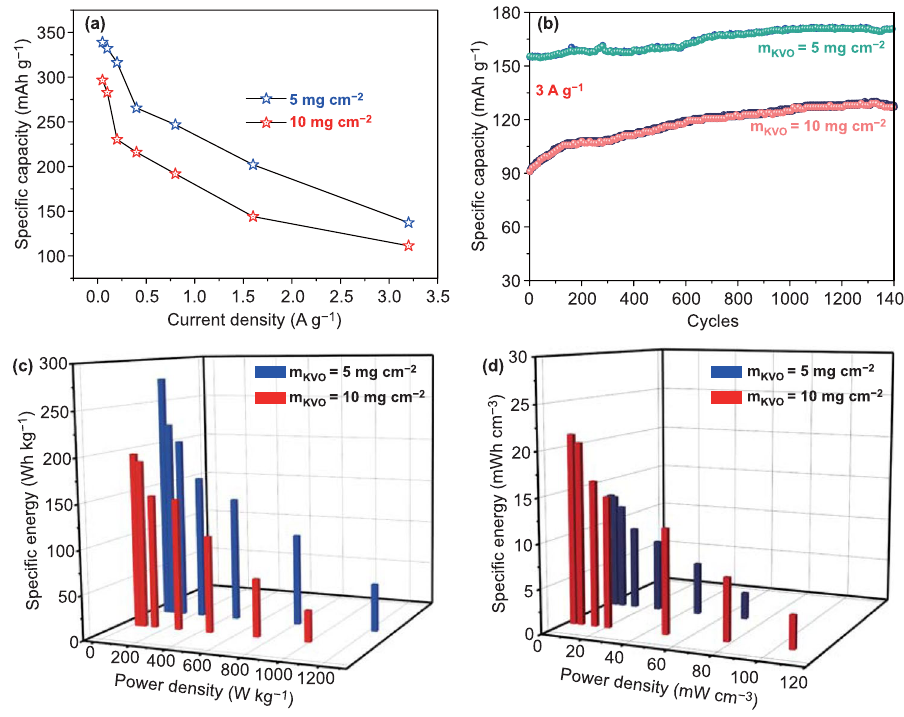
Fig. 7 High mass loading Zn//KVO cell: a Rate performance. b cycling performance. Energy densities and power densities of the cell based on c KVO mass and d the volume of the